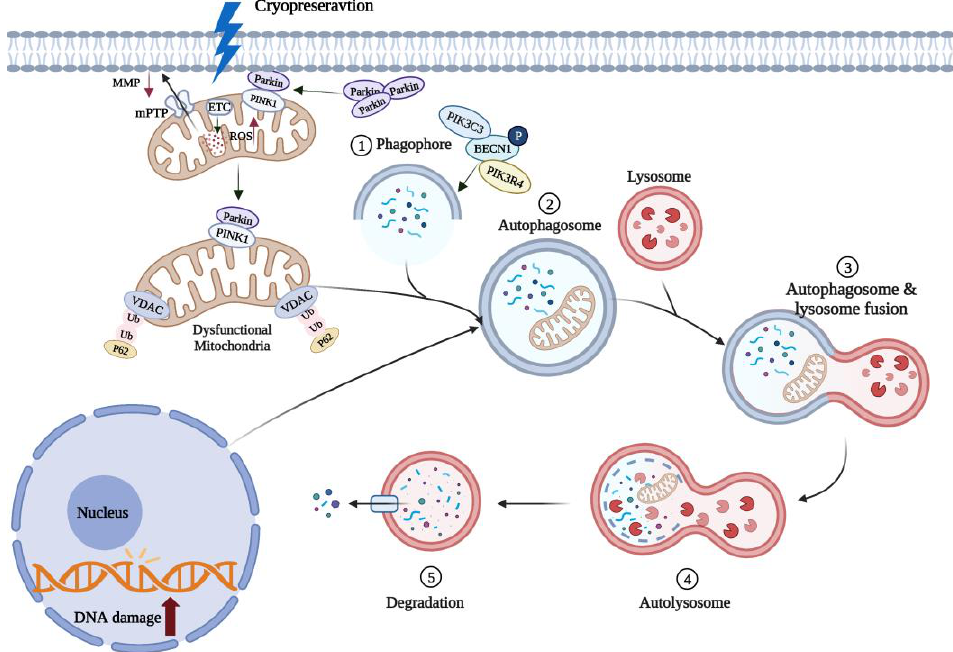
Figure 3. Mitophagy can remove oxidized mitochondria in oocytes. Cryopreservation causes oxida- tive stress in oocytes and rapid depolarization of MMP, which promotes Parkin entry into damaged mitochondria. Parkin induces polyubiquitination of VDAC in mitochondria, and ubiquitinated VDAC recruits p62 into mitochondria to induce mitophagy. These damaged mitochondria are phagocytosed by autophagic vesicles to form autophagosomes. Mature autophagosomes fuse with lysosomes to form autolysosomes, and the contained mitochondria are subsequently degraded. ↑ and ↓ , respectively, indicate a significant increase or decrease. Created with BioRender.com (accessed on 19 October